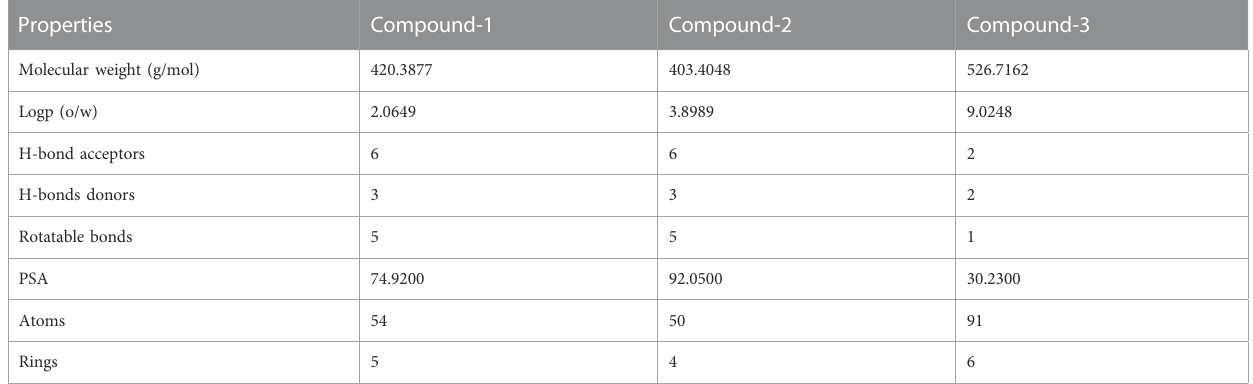
TABLE 6 The analyses of physicochemical Properties of the top 3 selected